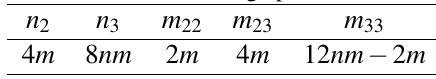
Table 6 Vertex and edge partitions of